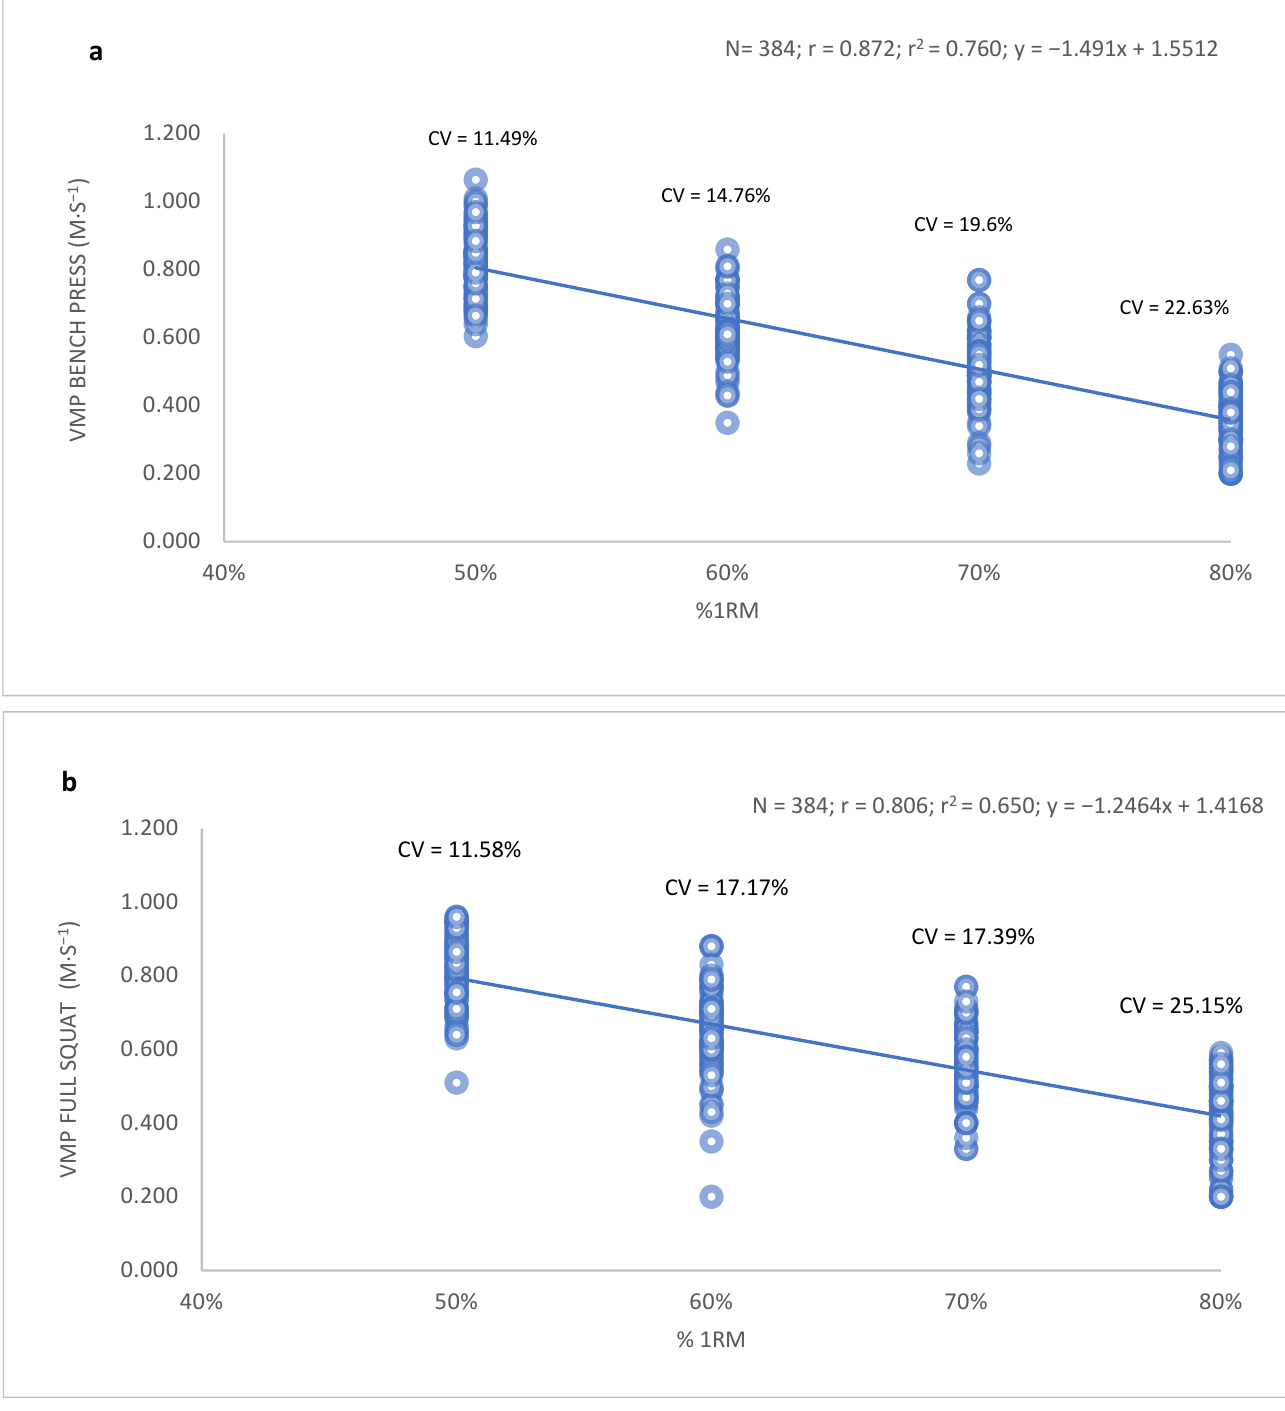
Figure 1. Relationship between MPV and relative load (%1RM) in the group of women for ( a ) the bench press and ( b ) full squat movements. Data were obtained from the values of the mobilization velocity of the isoinertial progressive load carried out in the sample of 96 young women .